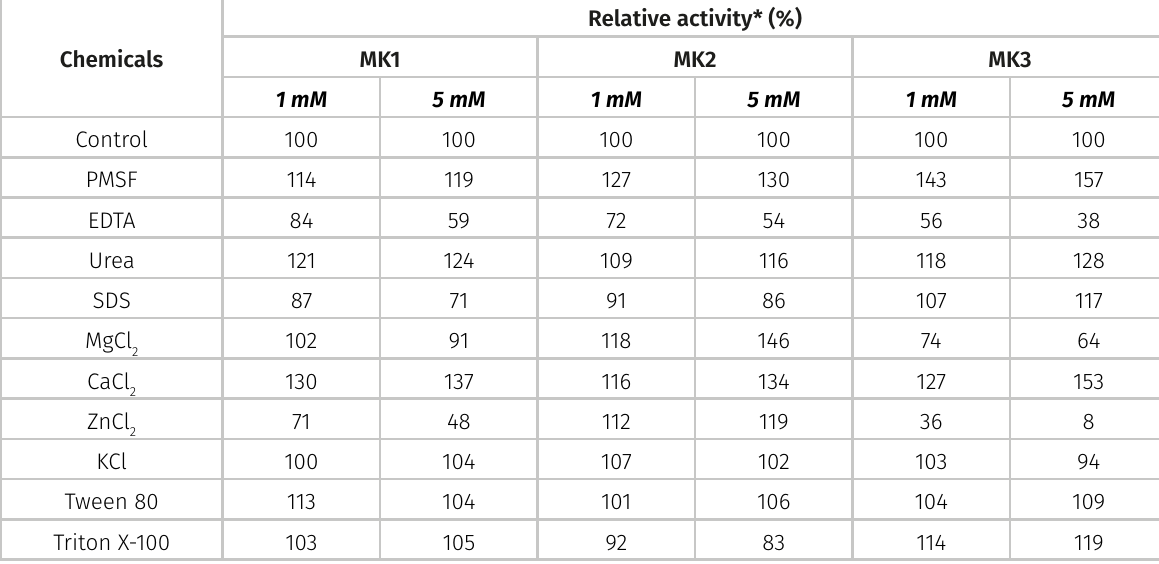
Table I. Effect of some chemicals on the activity of Bacillus sp. MK1, MK2, and MK3 keratinases.